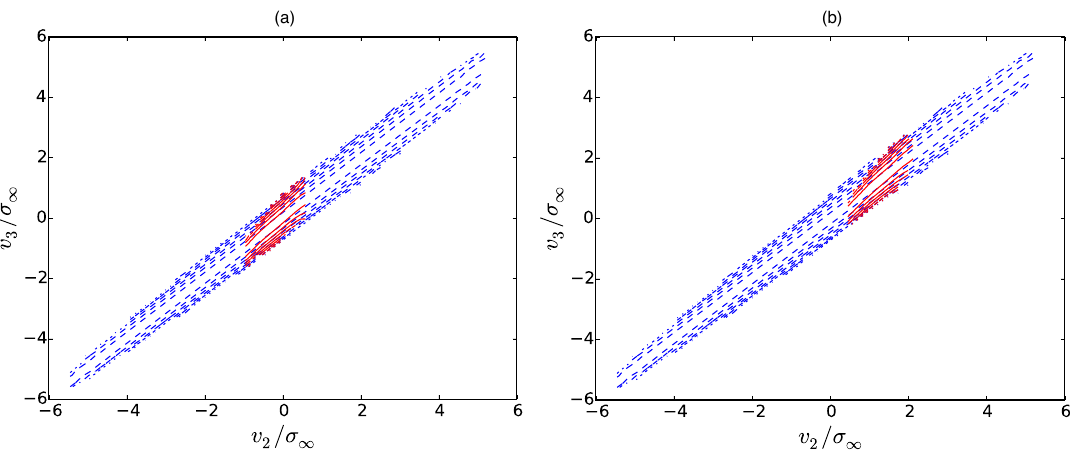
Figure 16. ( a ) examination of the Markov property (28) from DNS of the nonlocal case for ∆ r = 0.2 λ and v 1 = 0 via a logarithmic contour plot. ( b ) same as in ( a ), but for v 1 = σ ∞ . The Markov property is